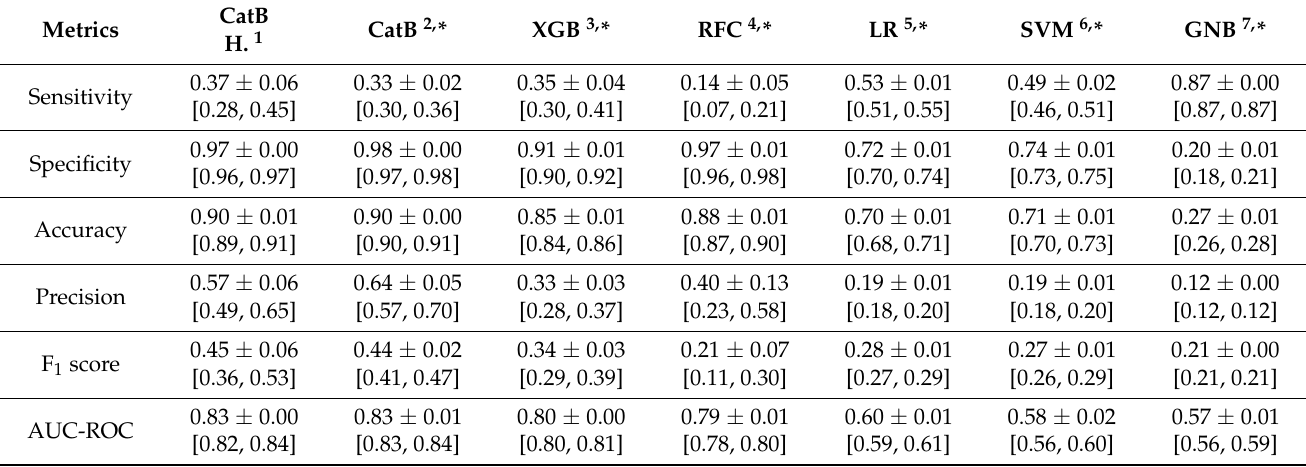
Figure 5. ROC curves of the classifiers. Table 4. Results of the TAVI mortality prediction model and comparison with other